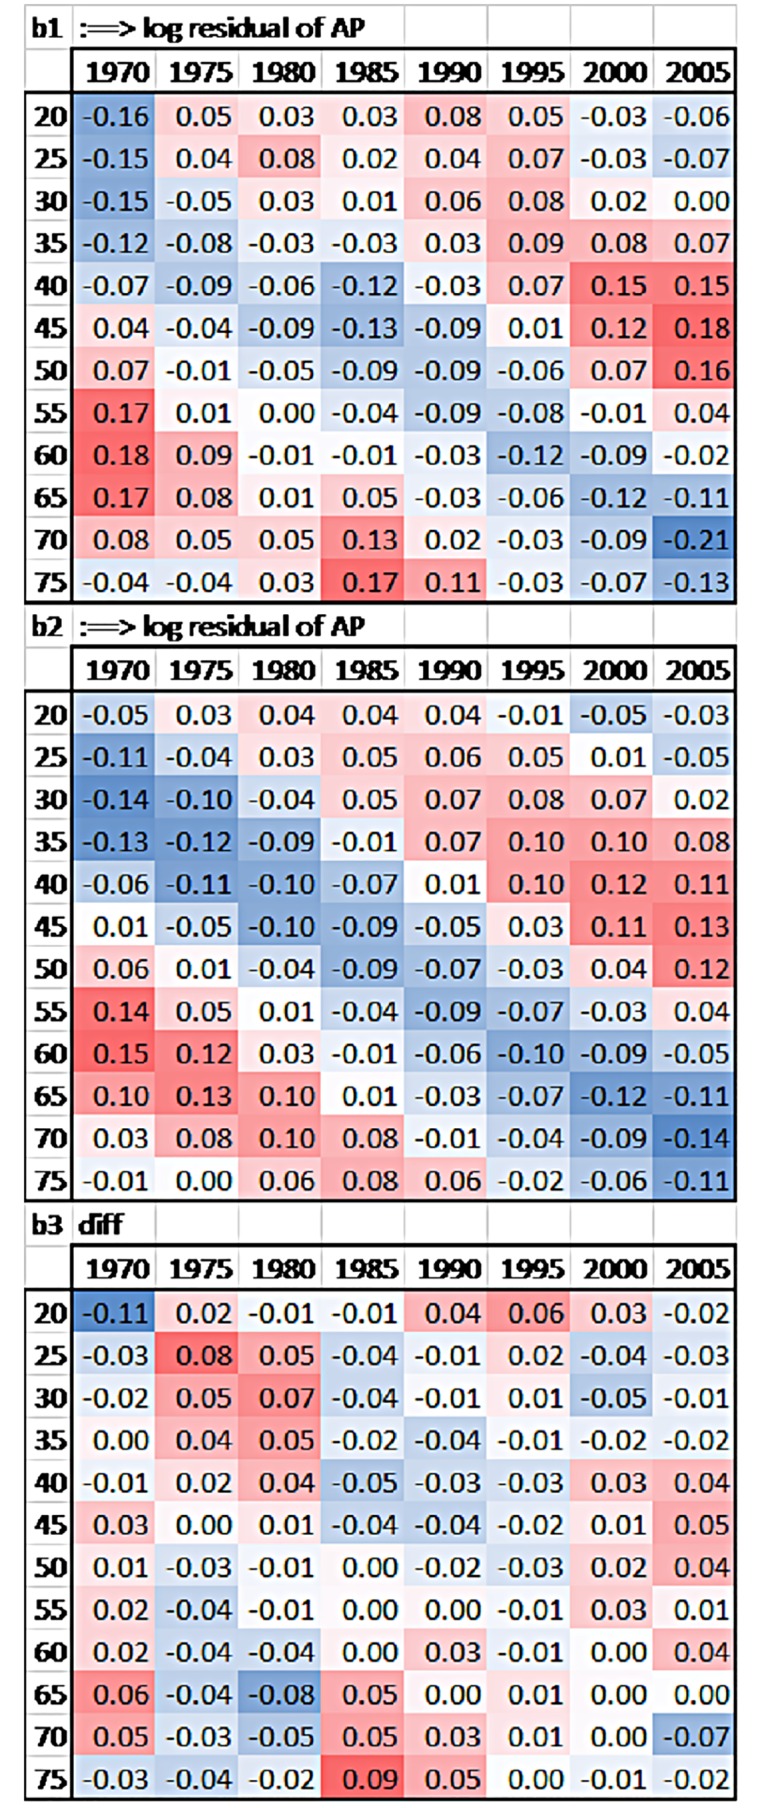
Hypothetical versus empirical suicide fluctuations: The U.S. case.Note. See legend of Fig 3 for explanations, for reasons of space only b1-b3 are presented.